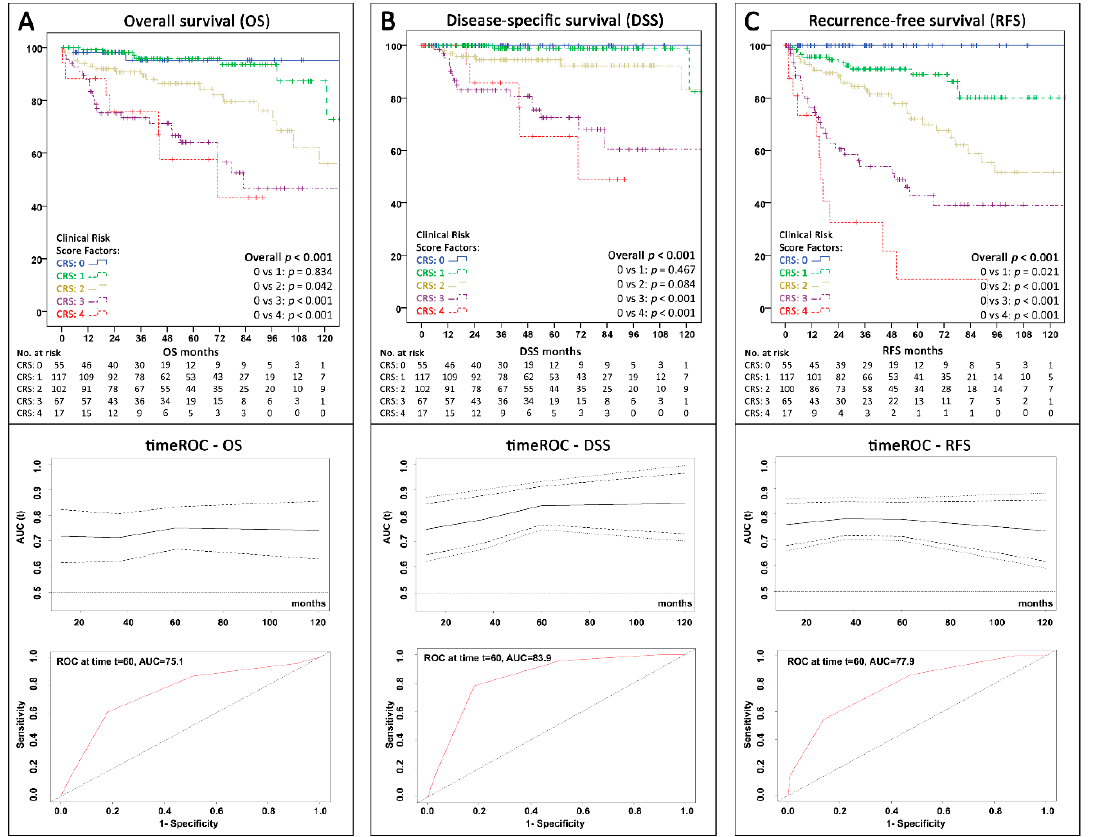
Figure 4. Kaplan–Meier curves with time-dependent ROC ( + 95% CI) over 120 months and AUC at 60 months showing the survival and predictive value according to the extended version of the proposed clinical risk score with 4 factors (World Health Organization (WHO) grading G1 vs. G2 / G3, presence of metastases, CRP ≥ 0.2 mg / dL, and primary tumor-size ≥ 3 cm) for the whole cohort (n = 358; grading missing = 6) ( A ) Overall survival ( B ) Disease-specific survival (death due to panNEN progression) ( C ) Recurrence-free survival. AUC = Area under the curve; CRS = Clinical risk score; ROC = receiver operating characteristics; t60 = timepoint 60 months; timeROC = time-dependent receiver operating characteristics